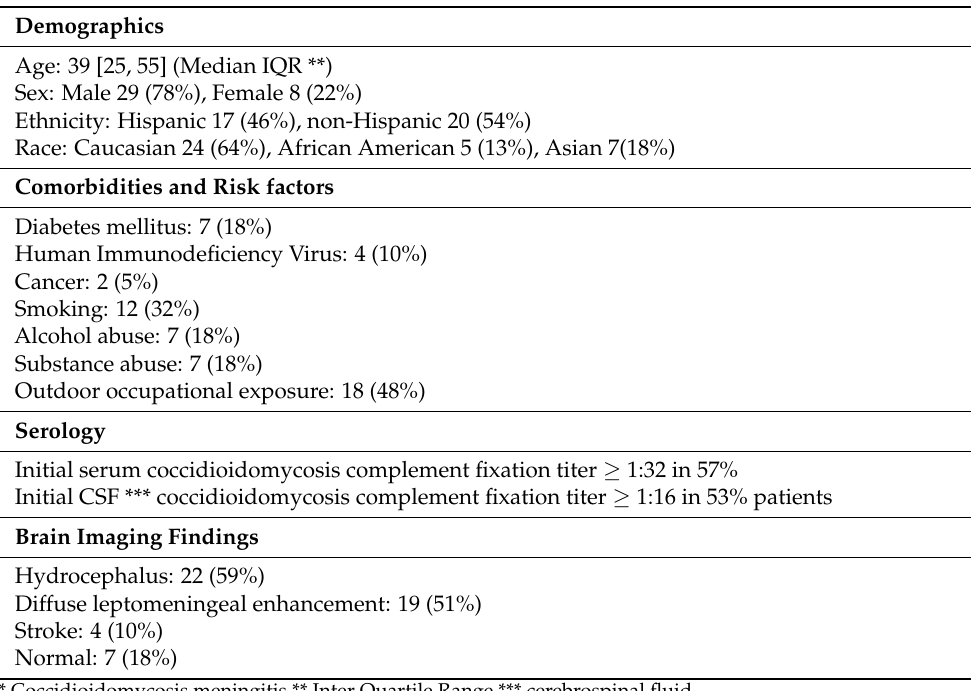
(Table 1). Approximately 50% of the study population had occupational outdoor exposure to coccidioidomycosis. Table 1. Characteristics of Patients with CM * (N = 37).